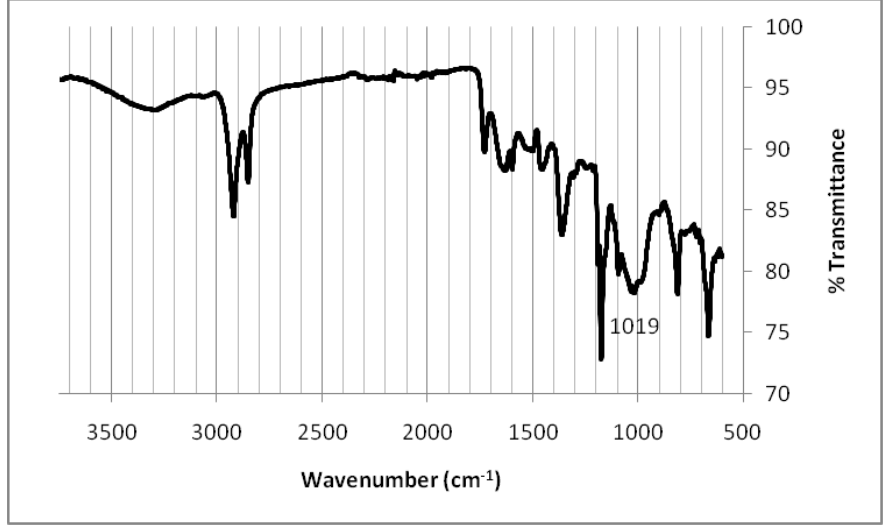
Figure 6. FTIR of the C6 aminated tea leaves.